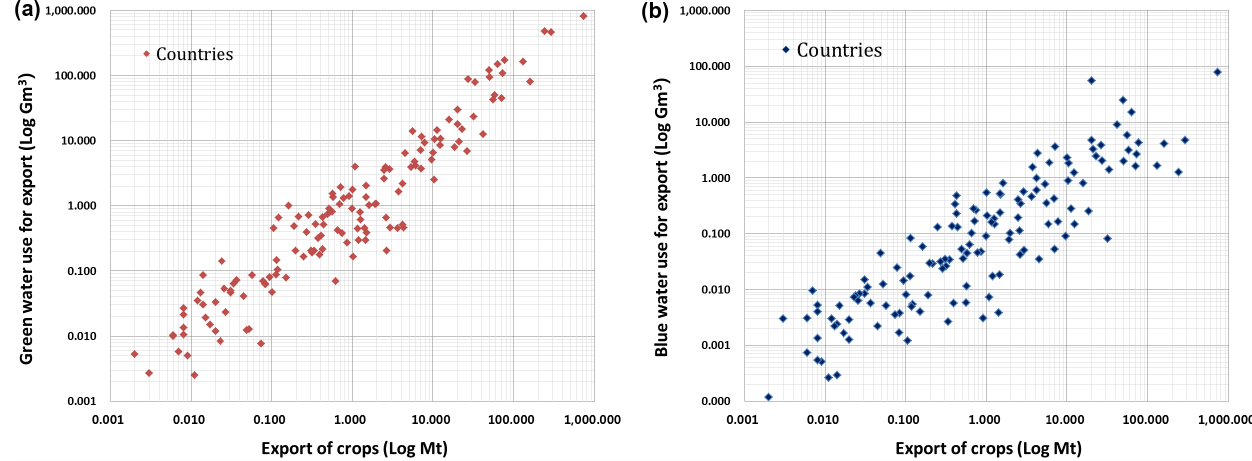
Figure 1. A comparison between virtual water export and crop export during the period 2006–2010 (wheat, barley, rice, rye, sorghum, maize, and bean crops). (a) Crop export and green water export and (b) crop export and blue water export.